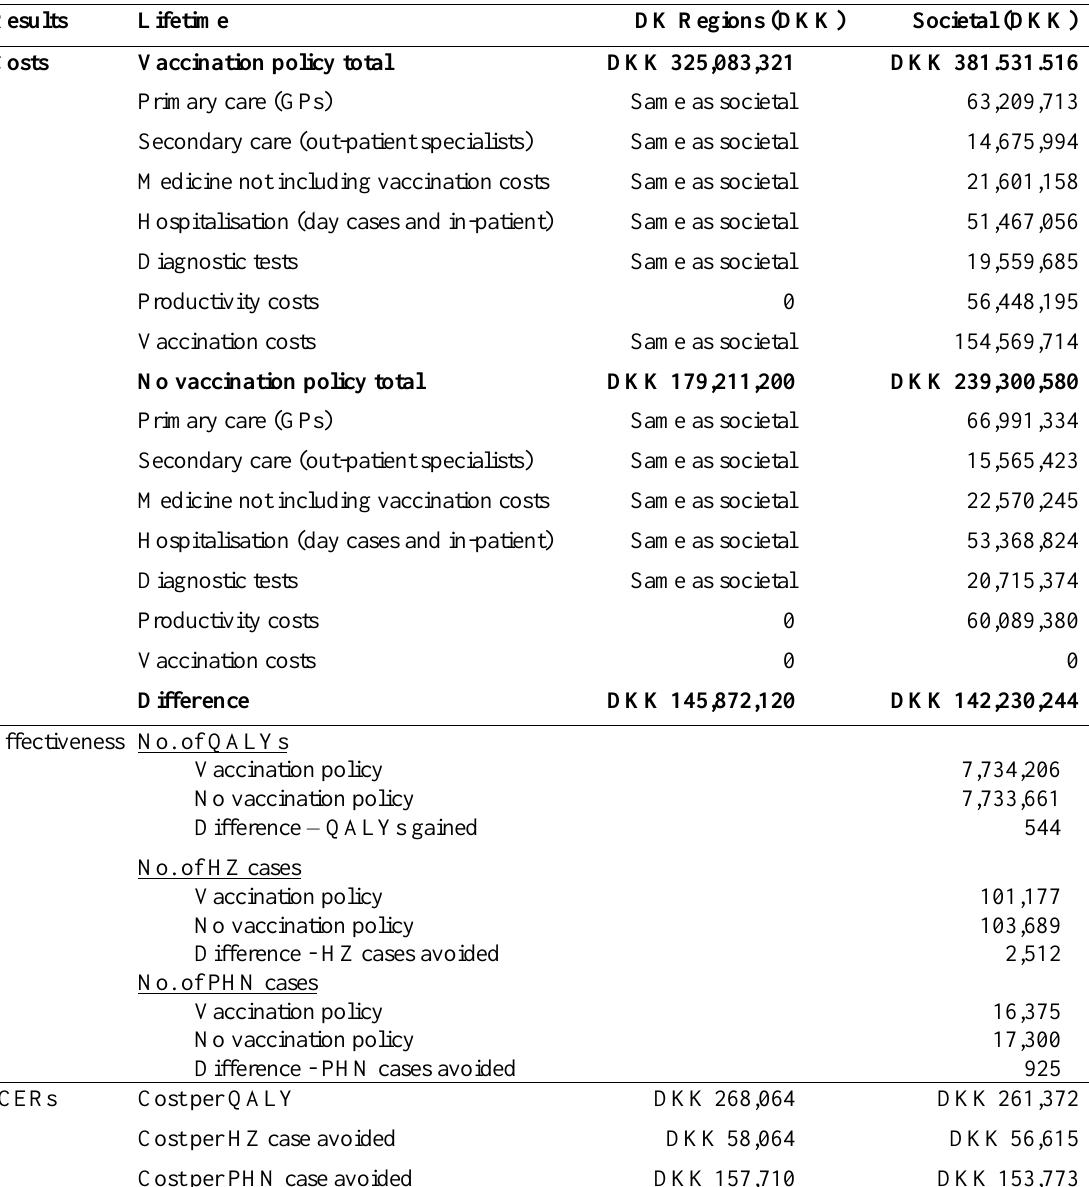
Table 7: Base case cost-effectiveness